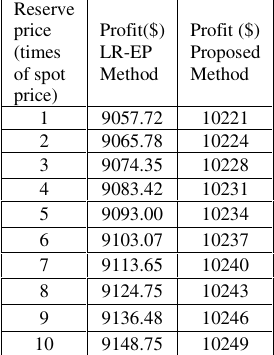
Table III Effect of Reserve Price in Payment Method A (r=0.005)